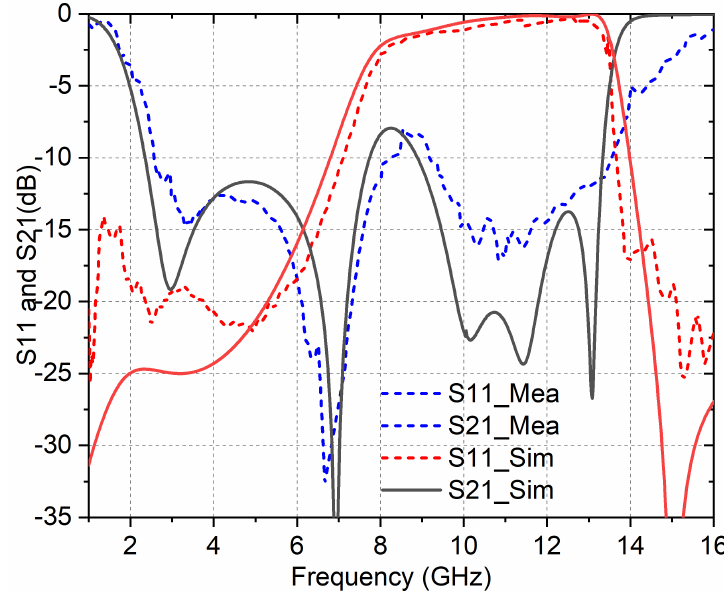
Figure 9. Measured and simulated results of the normal incidence.